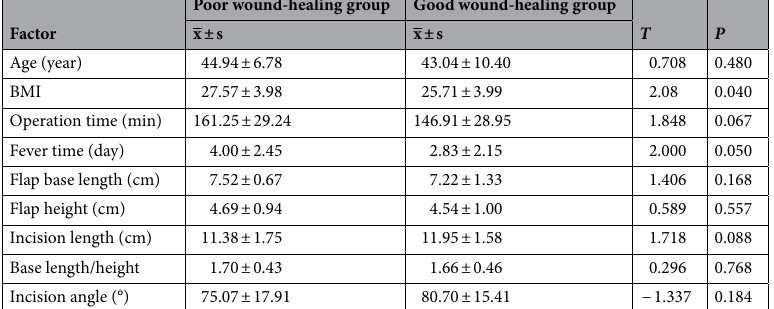
Table 2. Comparison of quantitative factors.